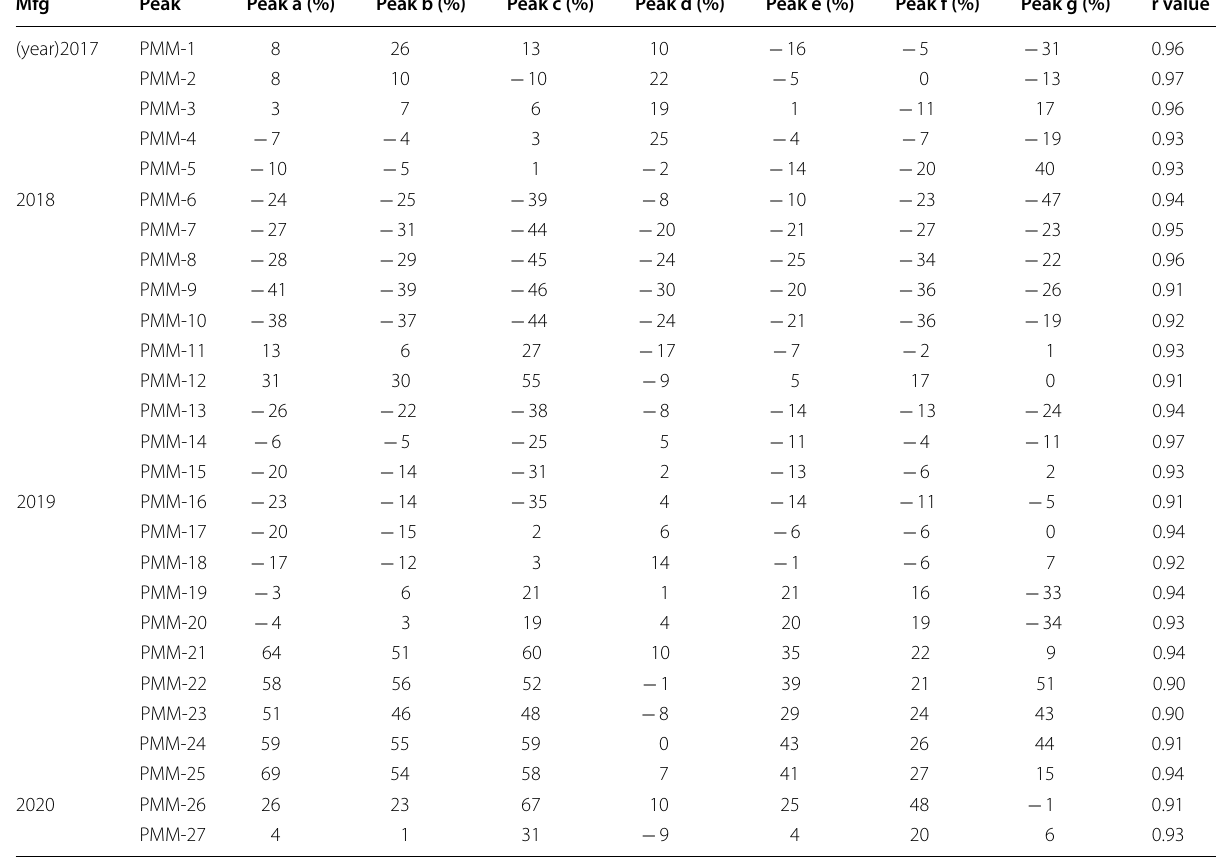
Table 5 Equivalent correlation coefficient of